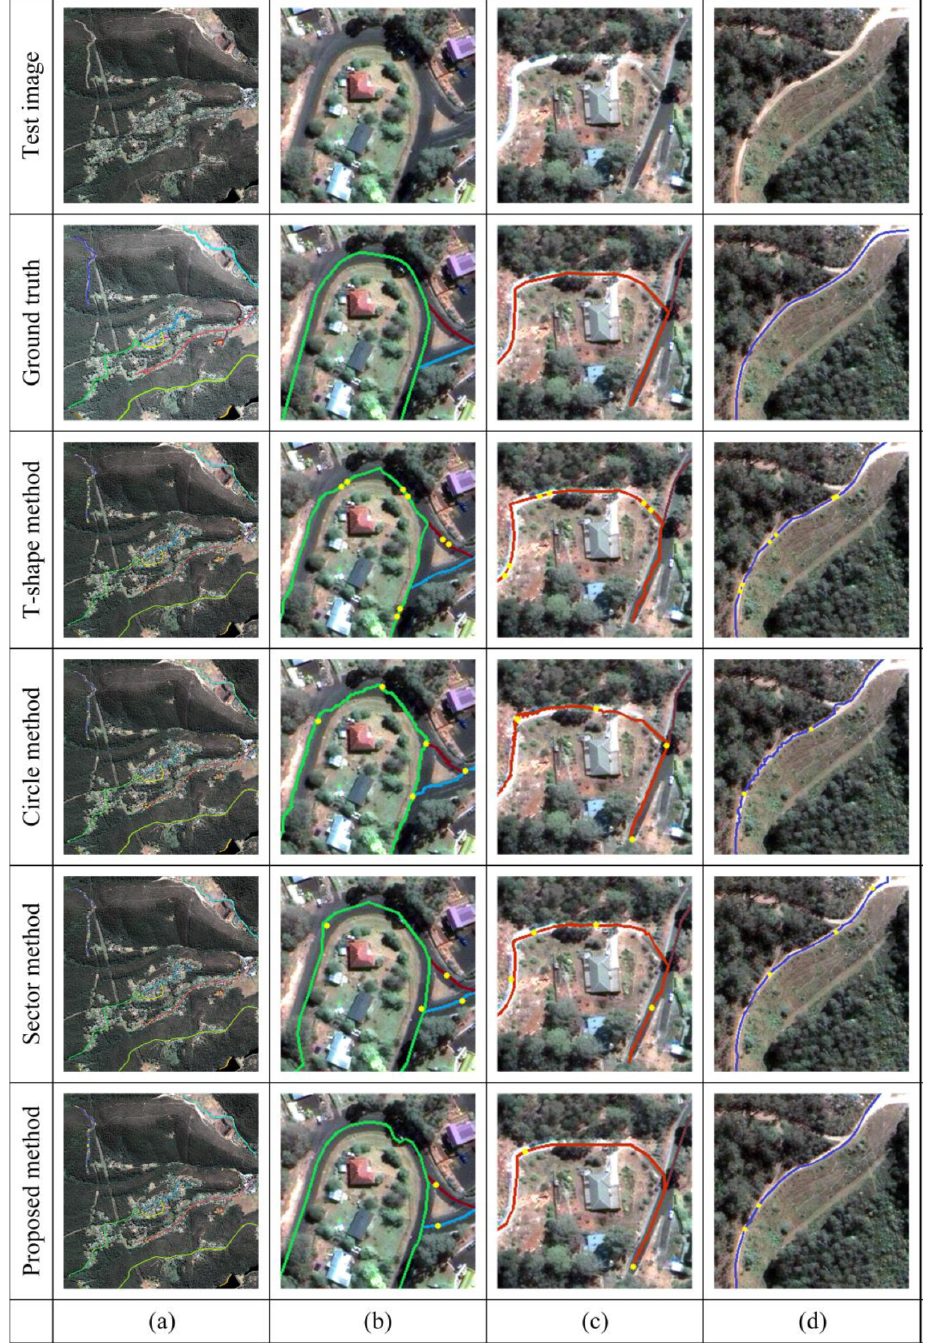
Figure 18. This is a figure. The results of road extraction with different algorithms in the town of GeoEye-1 (different colored curves represent different routes).